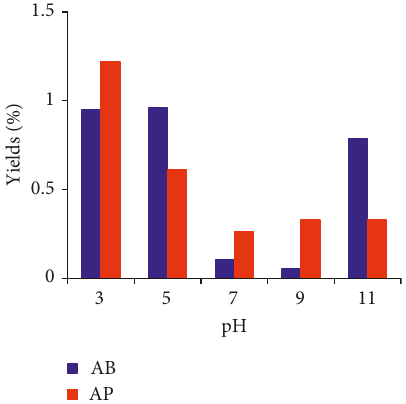
Figure 19: Desorption yields of methyl green at different pH